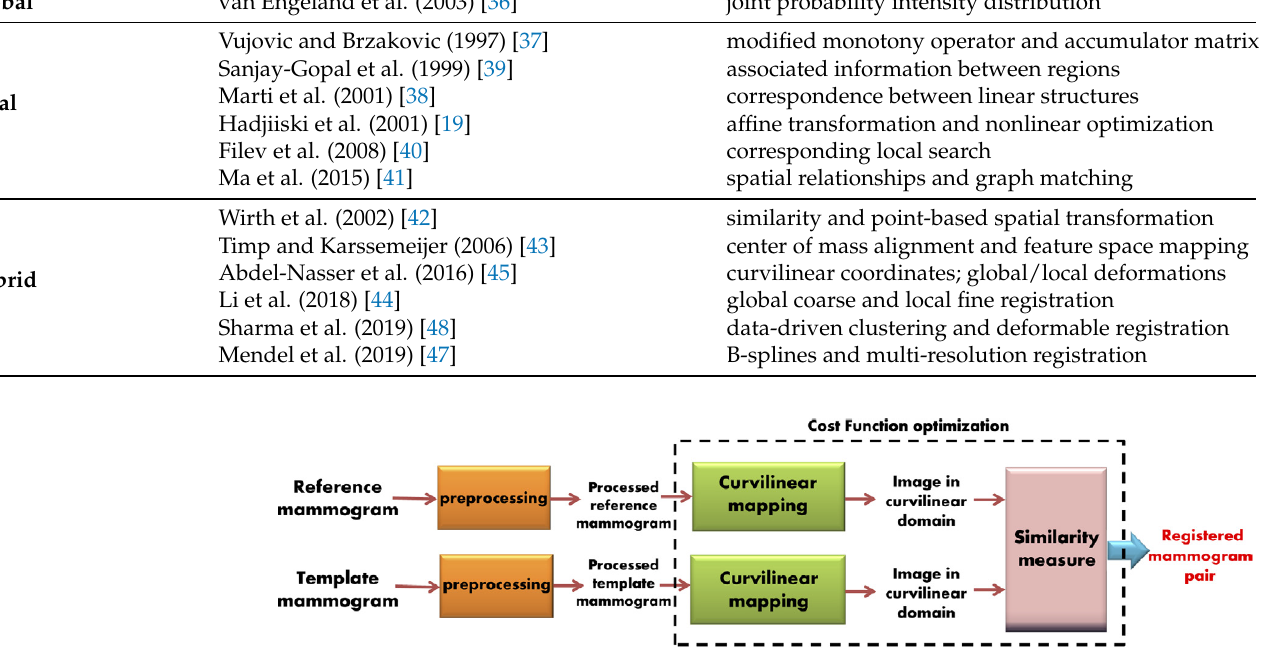
Figure 3. Proposed mammogram registration framework using optimized curvilinear coordinates (reprint with permission from